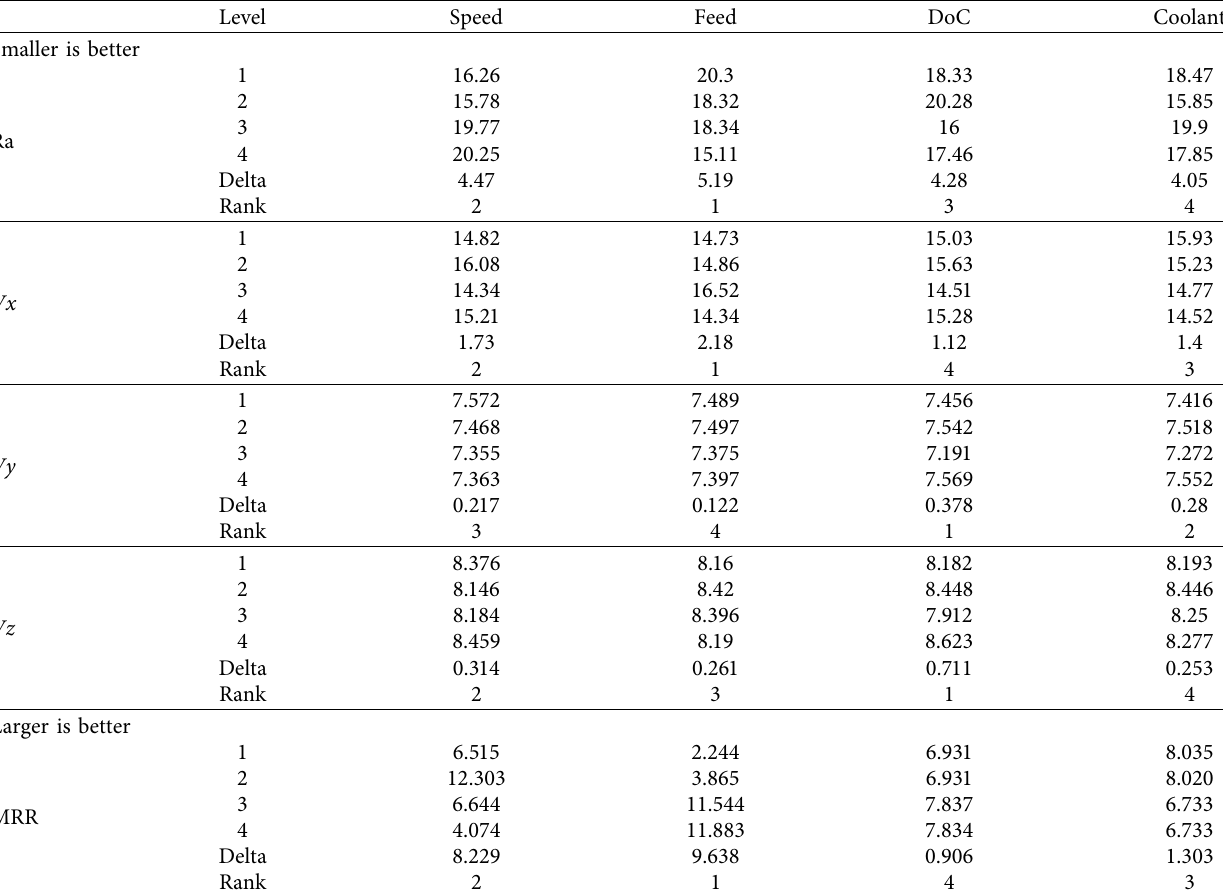
Table 4: S/N values for individual